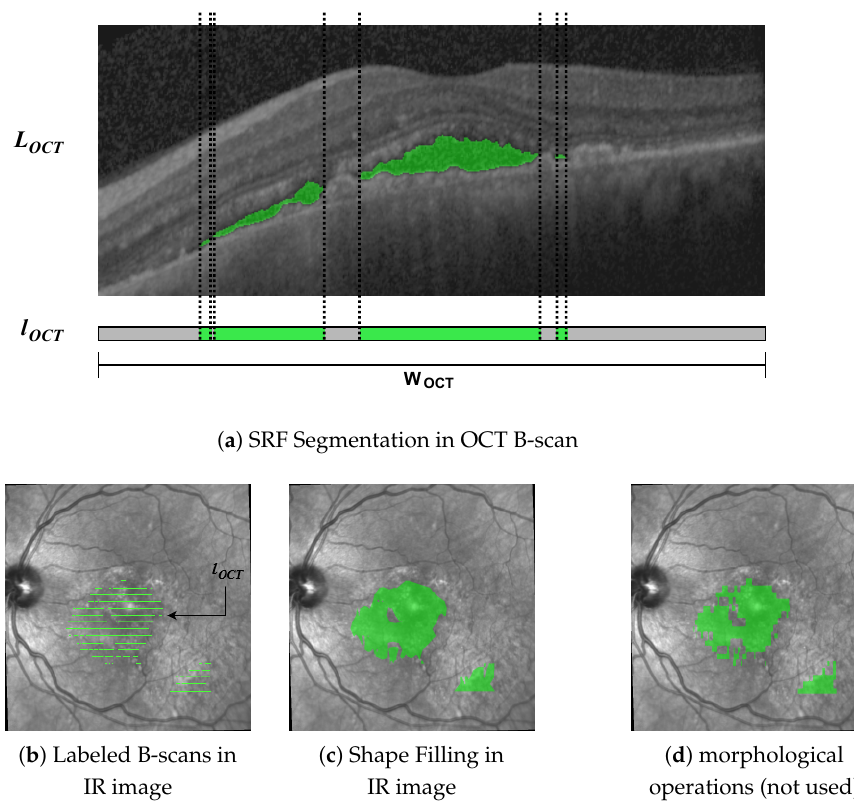
Figure 3. Segmentation masks throughout the different steps in our pipeline. We projected segmenta- tions in the OCT B-scans ( a ) onto the IR image ( b ). To close the gaps between the B-scans, we used shape interpolation ( c ), which yielded better results than morphological dilation and closing ( d